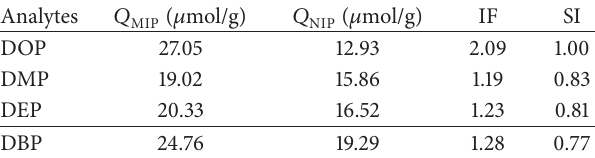
Table 1: Maximum binding number ( 𝑄 max ), imprinting factors (IF), and standardized selectivity (SI) for the structurally related compounds of DOP.